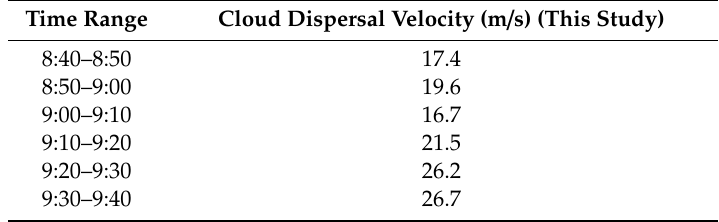
Table 3. Cloud dispersal velocities calculated with ECV camera footage.